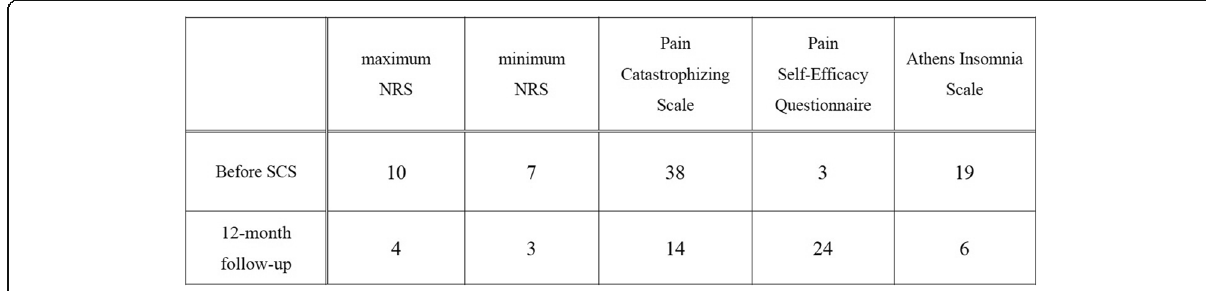
Fig. 3 The patient ’ s pain and sleep progress pre- and post-SCS implantation. The patient ’ s subjective numerical values concerning all of